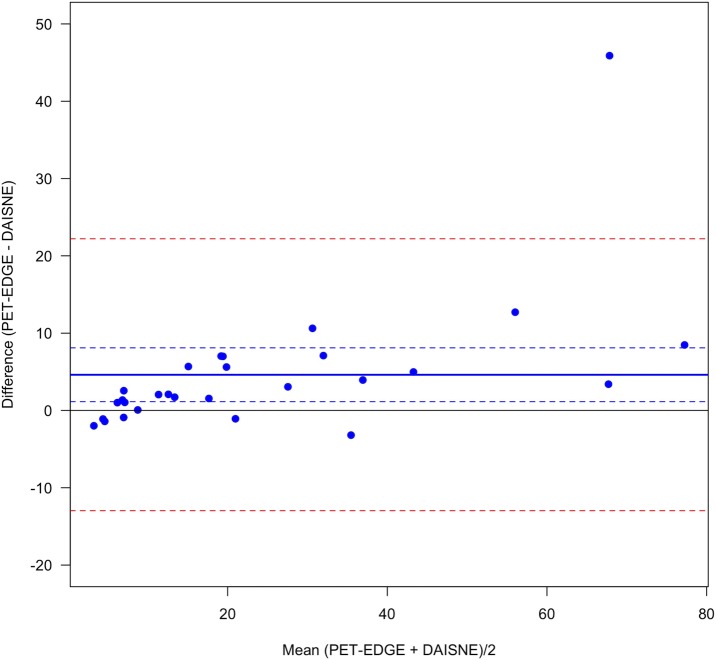
Variability between PET-EDGE and DAISNE method.Bland-Altman plot. (Solid blue line) Bias. (Dashed blue lines) Bias 95% confidence interval. (Dashed red lines) Difference 95% confidence interval.